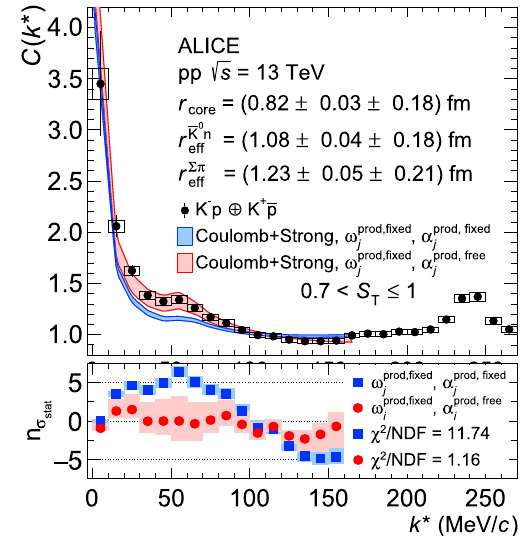
Fig. 4 (K − p ⊕ K + p) correlation functions obtained in pp collisions at √ s = 13 TeV. The measured data points are taken from [38] and have been corrected for finite experimental momentum resolution and for residual correlations as described in Sect.4.1. Measured data are shown by the black markers, the vertical error bars and the boxes represent the statistical and systematic uncertainties, respectively. The red and blue bands in the upper panels represents the model calculations and its systematic uncertainty as described in the text. The r core and r eff values of the source are reported with their statistical and systematical uncertainties. Bottom panels represent the data-to-model comparison as described in the